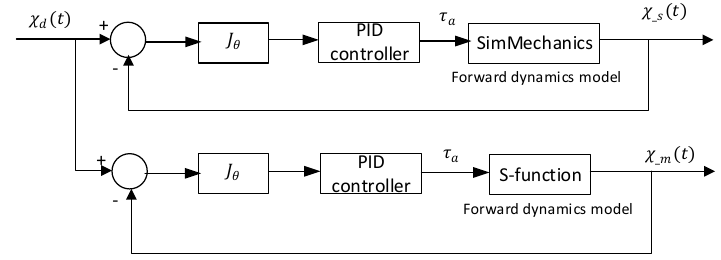
Figure 7. Dynamic model verification block diagram of 6-RSS parallel robot.